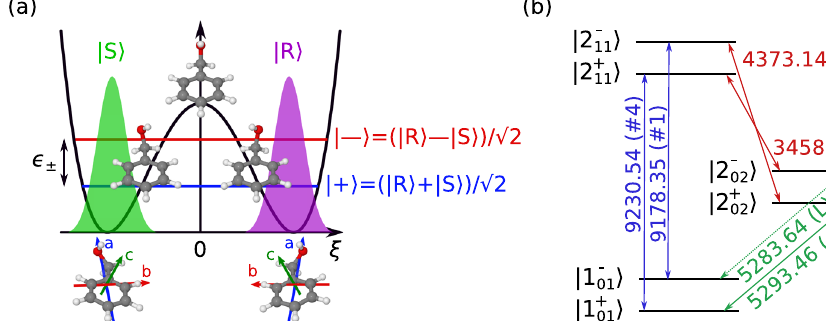
Fig. 1 | Double-well potential and rotational level scheme. a Schematic repre- sentation of the enantiomer interconversion mechanism in benzyl alcohol (BA). The ∣ ± i statesdenotethevibronicgroundstatewithoppositeparity.The ∣ R i and ∣ S i states represent the localized wavepackets of a particular chirality. ξ is the large amplitudemotioncoordinate. ϵ ± correspondstotheenergydifferencebetweenthe twotunnelingstates,whichisexperimentallydeterminedtobe492.816(2)MHzfor BA arising from a barrier with a height of about 280 cm − 121 . b Rotational level scheme of BA used in our experiment. Each rotational level is marked as J ± K